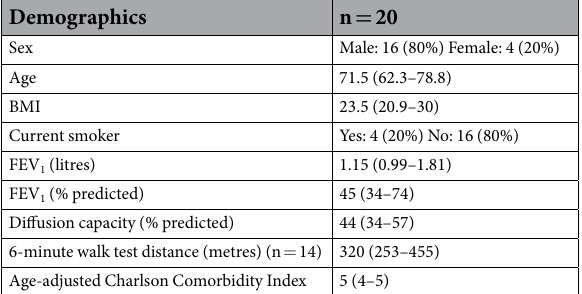
Demographics n = 20